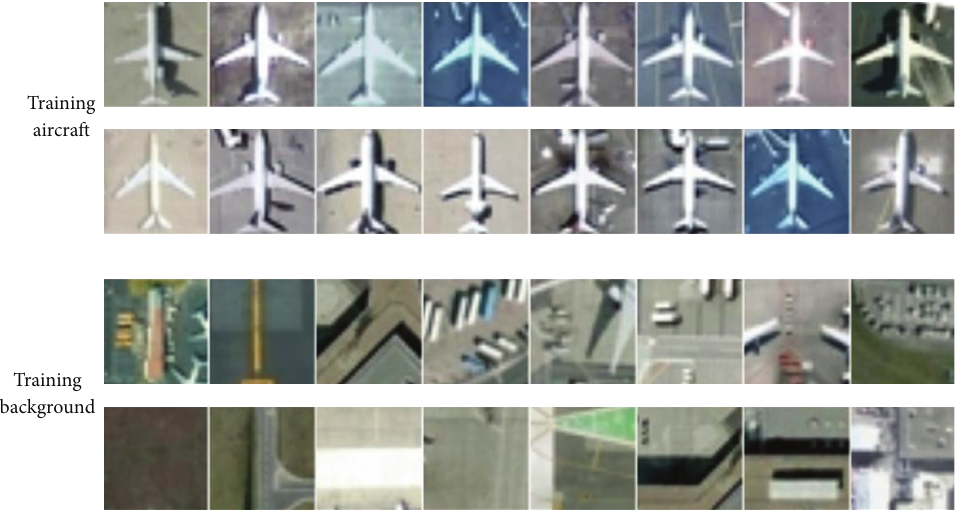
Figure 5: Examples of positive and negative image patches of training dataset.